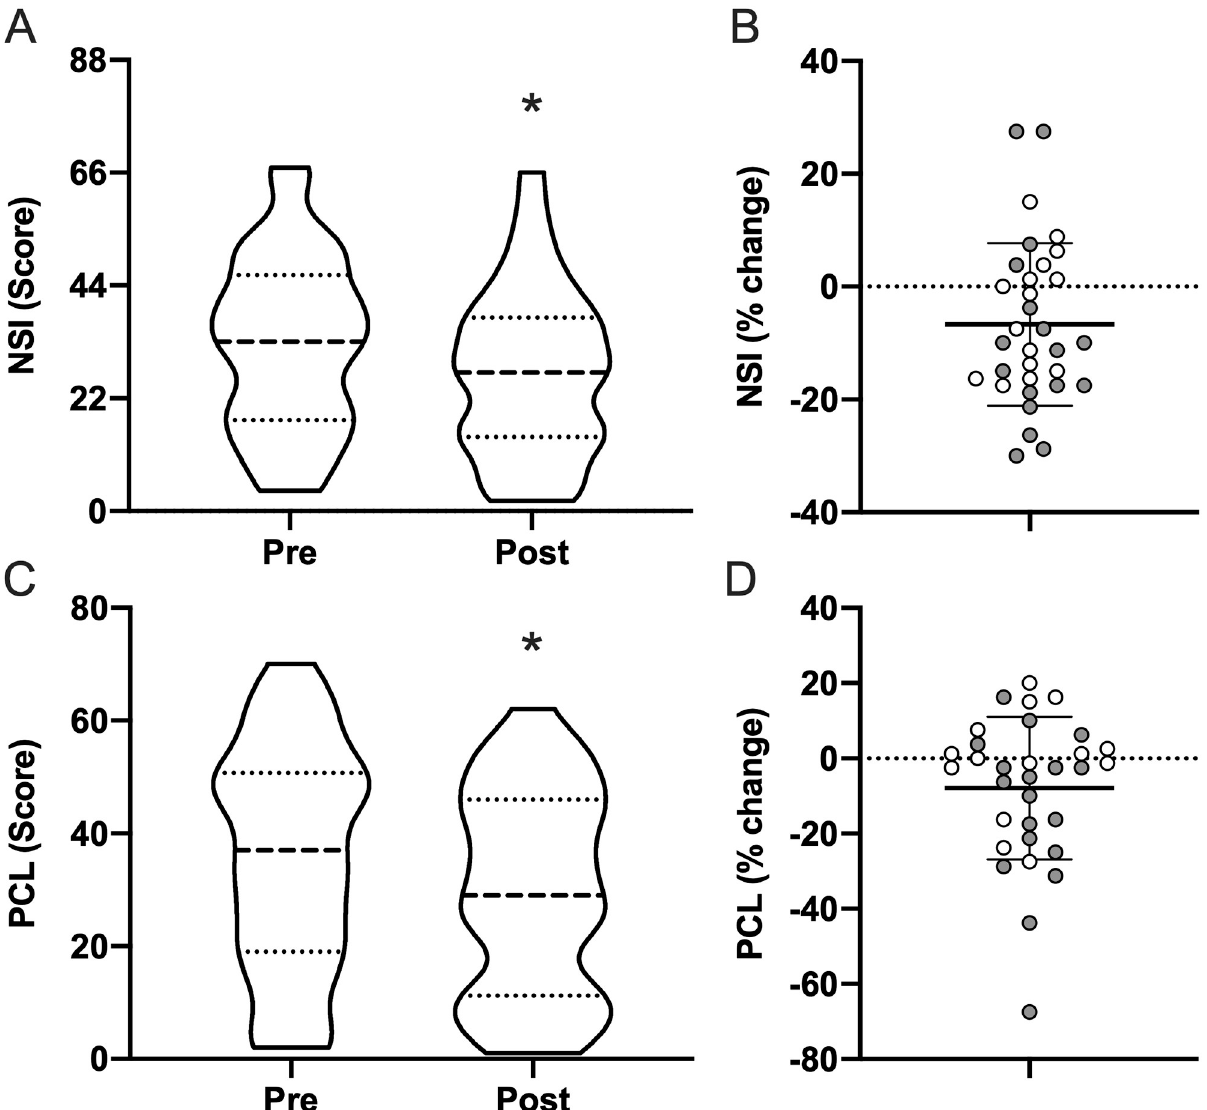
Fig 3. TBI-related symptom severity. Pre- and post-morning bright light therapy questionnaire scores for the ( A ) Neurobehavioral Symptom Inventory (NSI; range = 0–88; higher = worse brain injury related symptom severity) and ( C ) Post-traumatic stress disorder (PTSD) checklist-5 (PCL-5; range = 0–80; higher = worse PTSD symptom severity) displayed as truncated violin plots with moderate smoothing (dashed line = median score; dotted lines = 25% and 75% quartiles). Percent change in each Individual for ( B ) NSI and ( D ) PCL-5 normalized to the maximum score of each questionnaire, plotted with the mean and standard deviation overlaid. Shaded symbols are subjects with co-morbid post-traumatic stress disorder (PTSD), open symbols are subjects without co-morbid PTSD. � = p < 0.05 vs pre; paired two-tail t-test.